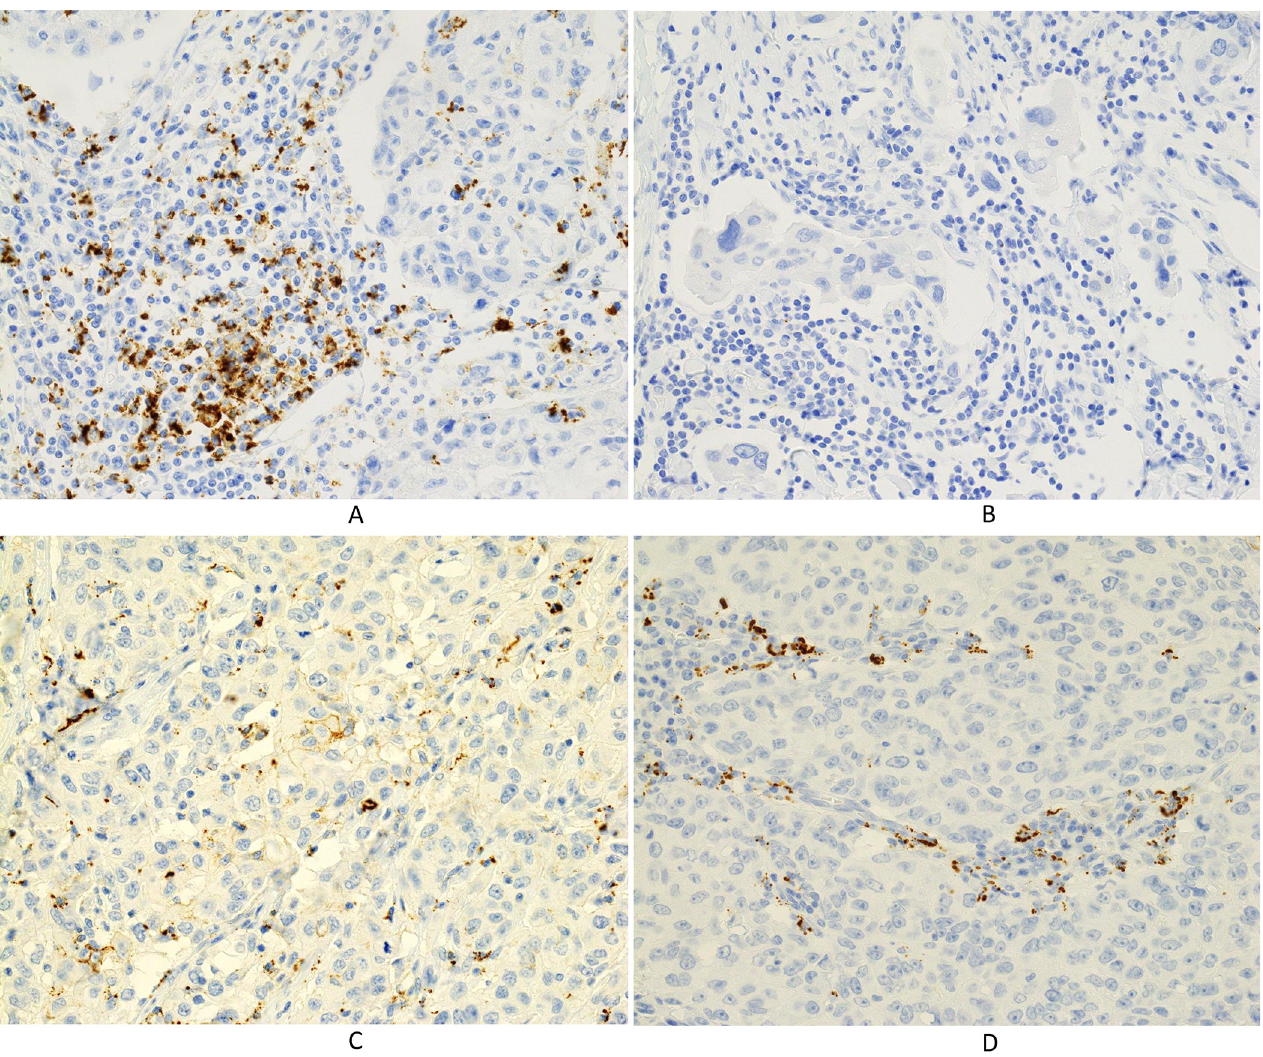
Fig 2. Immunohistochemical staining for PD-L1 using the SP142 assay. (A) PD-L1 is expressed in immune cells ( × 400). (B) No PD-L1 expression is noted in immune cells ( × 400). (C) PD-L1 is expressed in carcinoma cells ( × 400). (D) PD-L1 is not expressed in carcinoma cells ( ×